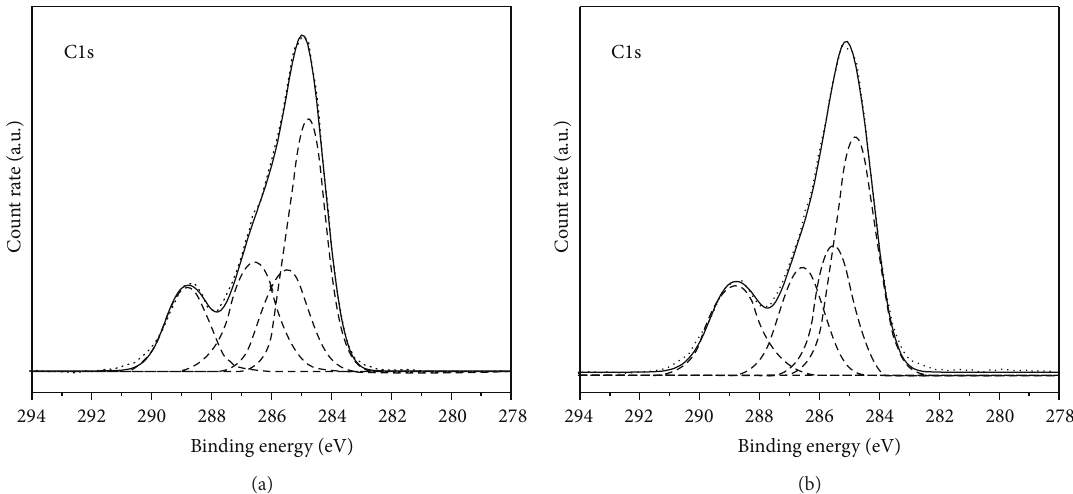
Figure 4: Measured C1s peaks of (a) untreated powder before deposition and (b) thick powder coating (dotted lines) including fits (dashed lines) for particular bonds and cumulative fit (solid lines).